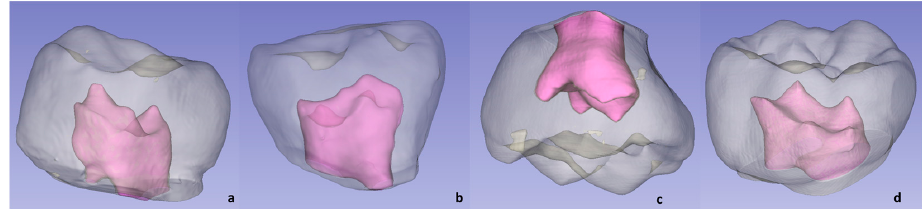
Figure 4. Three-dimensional reconstruction of primary molars’ teeth and pulp volumes: P1MS ( a ); P1MI ( b ); P2MS ( c ) and P2MI ( d ).